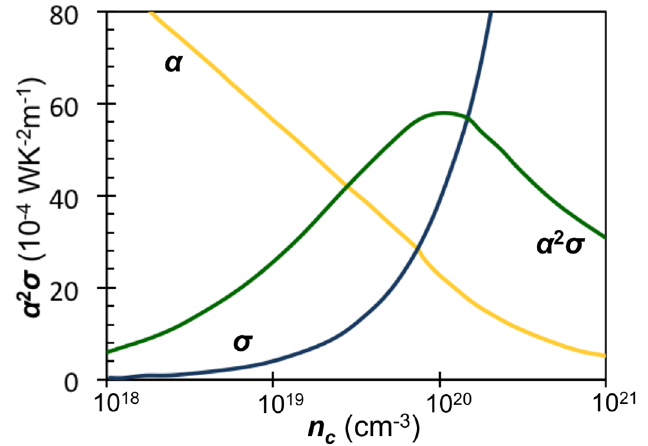
Figure 1. General relationship between Seebeck coefficient ( α ), conductivity ( σ ), and power factor ( α 2 σ ) as a function of carrier concentration ( n c ). Curves generated based on Bi 2 Te 3 [22,23] and can be expected to change in shape and magnitude based on material system.